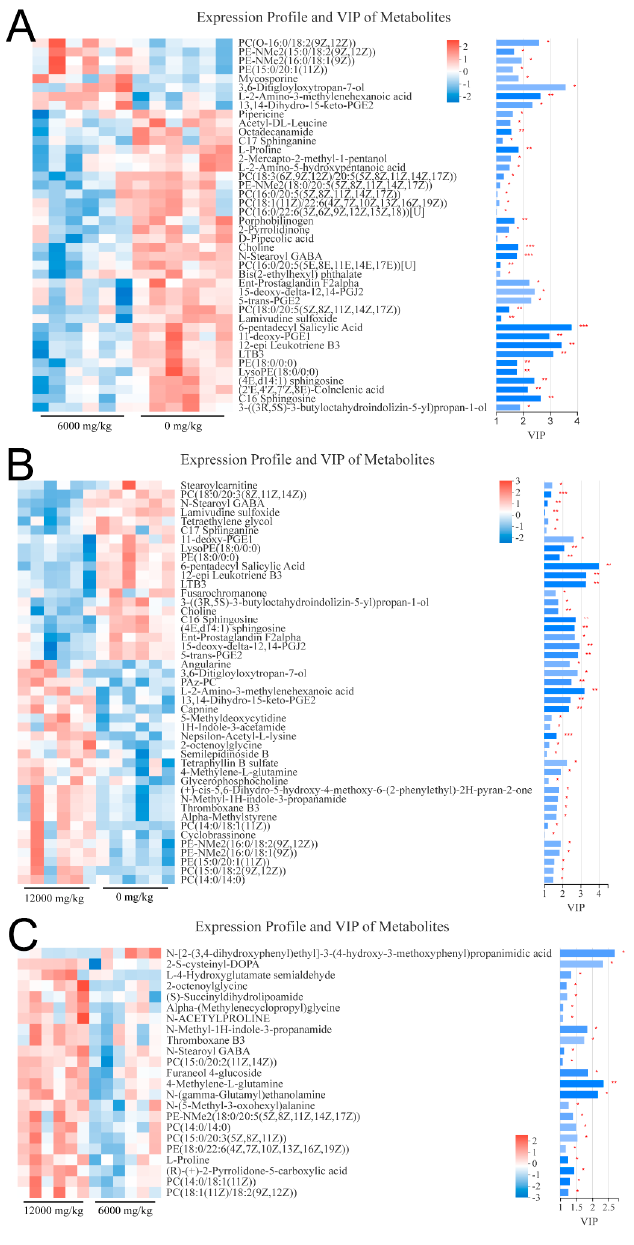
Figure 2. VIP values and expression levels of differential metabolites in the three compared groups: ( A ) 0 versus 6000 mg/kg; ( B ) 0 versus 12,000 mg/kg; ( C ) 6000 versus 12,000 mg/kg. * ( p < 0.05), ** ( p < 0.01) and *** ( p < 0.001).